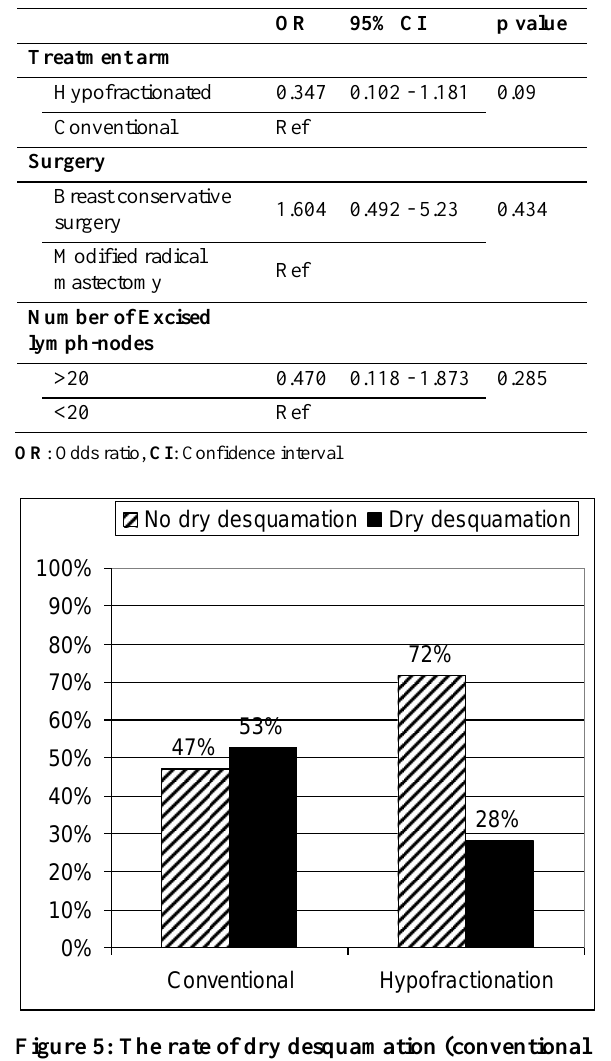
Table 3: Multivariate analysis for factors associated with lymphedema